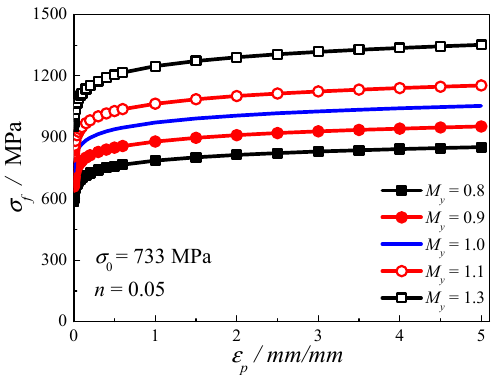
Figure 1. The true stress-strain curve of weld material with different strength mismatch ratios.